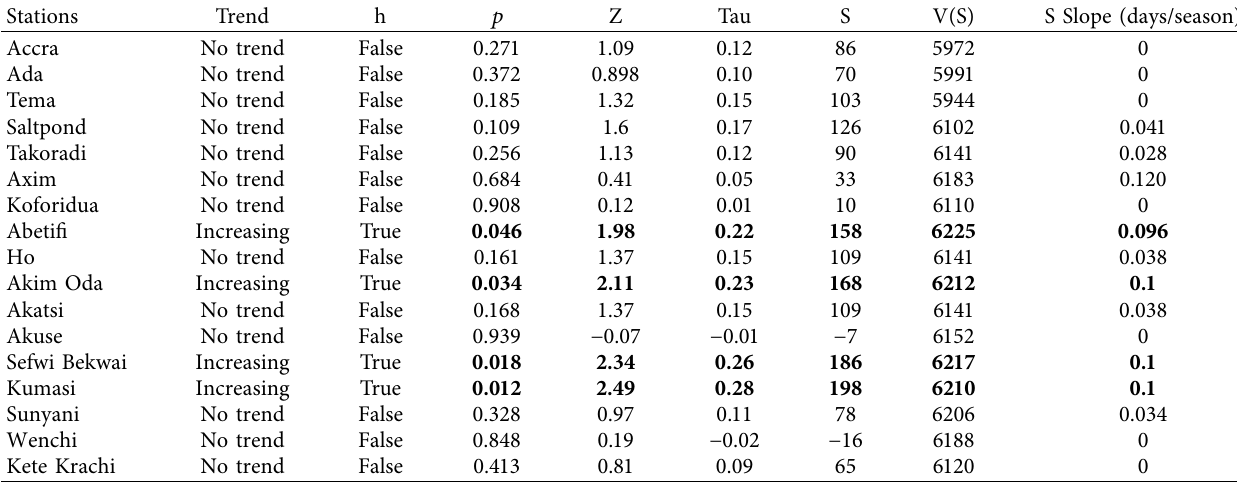
Table 7: Mann-Kendall trend analysis of Extremely Heavy Precipitation Days (R20).